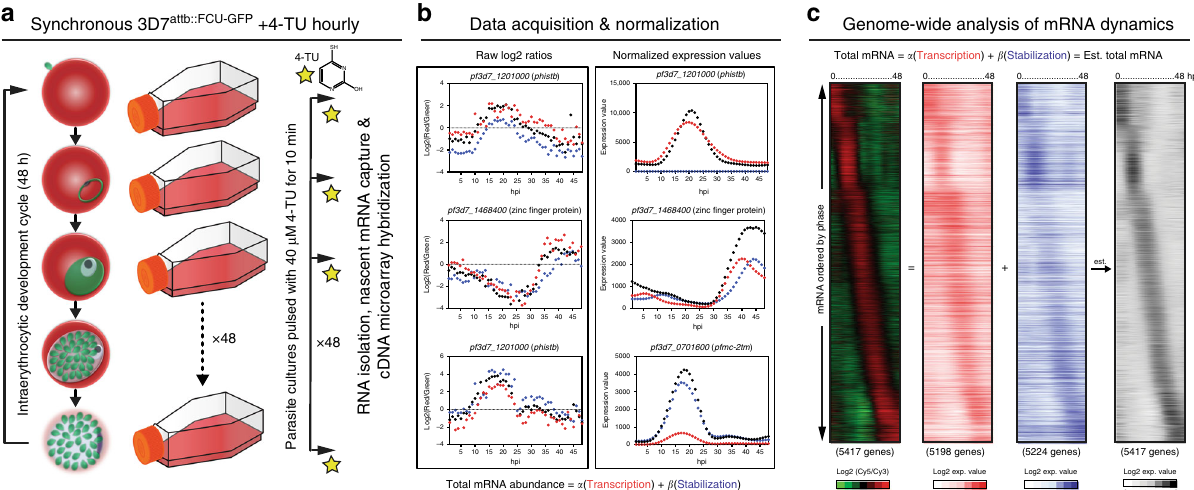
Fig. 1 Biosynthetic mRNA labeling and capture throughout the P. falciparum IDC reveals complex developmental mRNA dynamics. a Biosynthetic mRNA capture timecourse with 4-TU (40 µ M) labeling (10 min pulse) of highly synchronous transgenic 3D7 attB::fcu-gfp parasites every hour throughout the 48 h IDC followed by total RNA extraction. 4-TU labeled RNA is separated from the total RNA resulting in two fractions, transcribed (labeled) and stabilized (unlabeled). These RNAs and the total cellular RNA pool were quanti fi ed by DNA microarray analysis (Supplementary Fig. 2). b Data obtained by cDNA microarray was normalized and modeled to determine the contribution of nascent transcription (red circles) and stabilization (blue circles) to the total abundance pro fi le (black circles) for each gene. c The modeled expression values of nascent transcription (5207 genes, red) and stabilization (5236 genes, blue) values for each gene were ordered based on the peak timing of total abundance (5428 genes) during the 48 h IDC as determined by Lomb-Scargle analysis and displayed in a heatmap as the log 2 expression value. The summation of the expression values for both transcription and stabilization is displayed as a heatmap representing the estimated total mRNA abundance (5207 genes, black), recapitulating the canonical phaseogram of measured total mRNA abundance (left, RGB